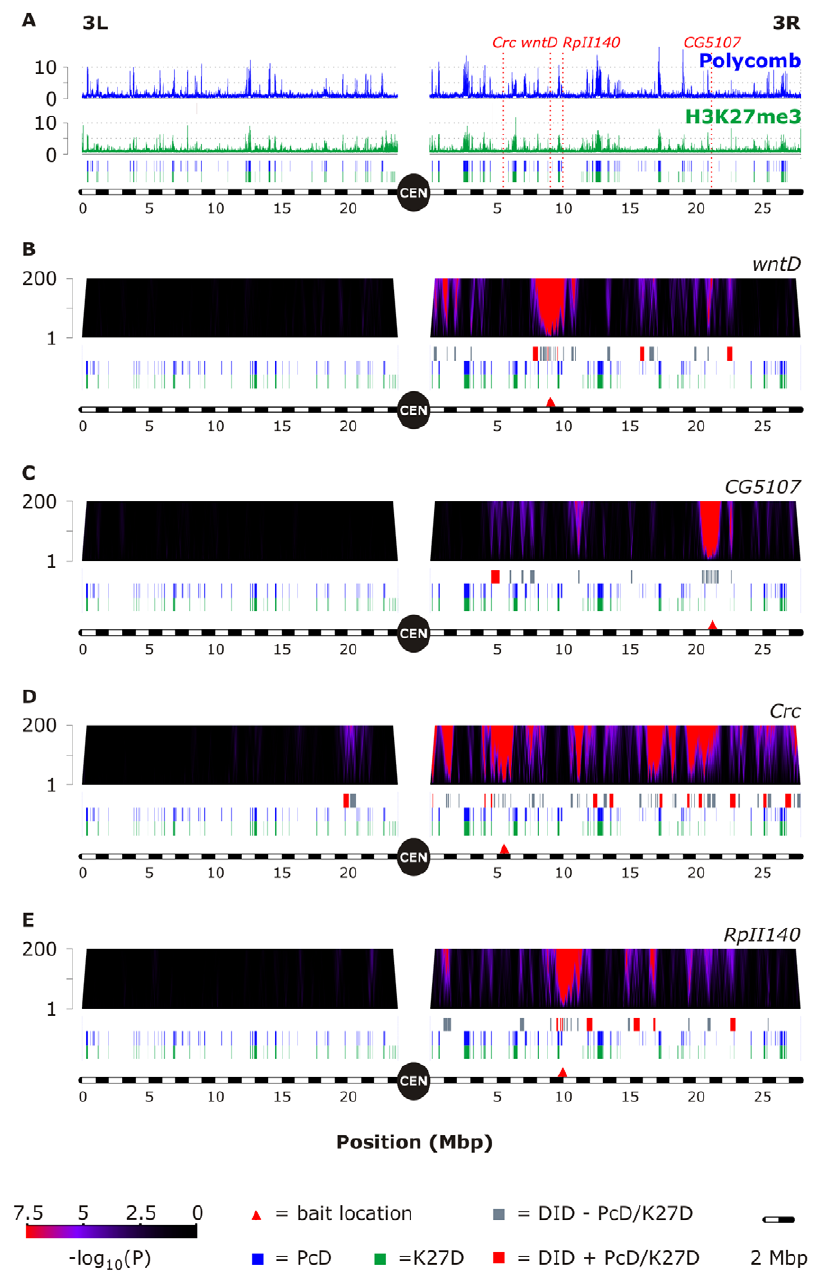
Figure 4. Non-target genes interact with other sequences than PcG target genes. (A) Position of four 4C baits that are not PcG target genes (red), plotted as in Figure 2A. (B–E) Long-range chromatin interactions for Wnt inhibitor of Dorsal ( wntD - B), CG5107 (C), Calreticulin ( Crc - D), and RNA polymerase II 140 kD subunit ( RpII140 - E). Plots are as in Figure 1B and Figure 2.